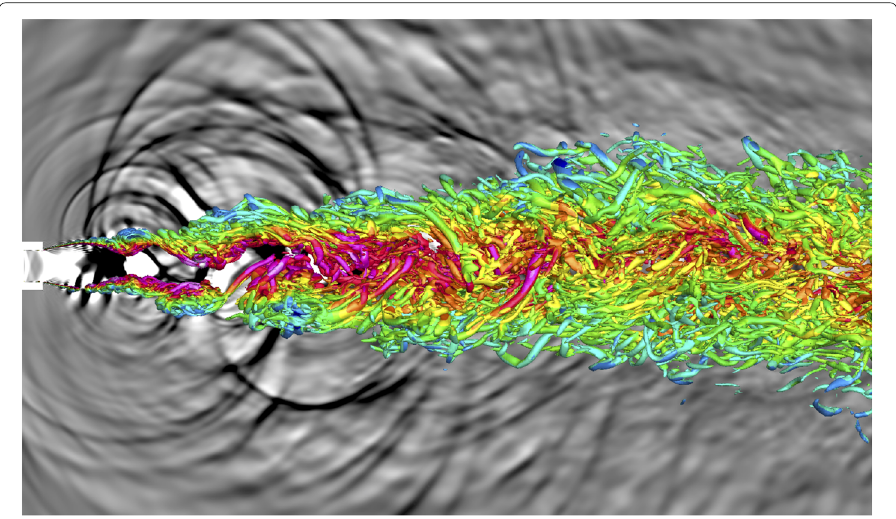
Fig. 20 Instantaneous snapshot of spanwise vorticity ω z and the dilatation in the plane z / h = 2.5 as the background. The isosurface of vorticity is colored with the amplitude of